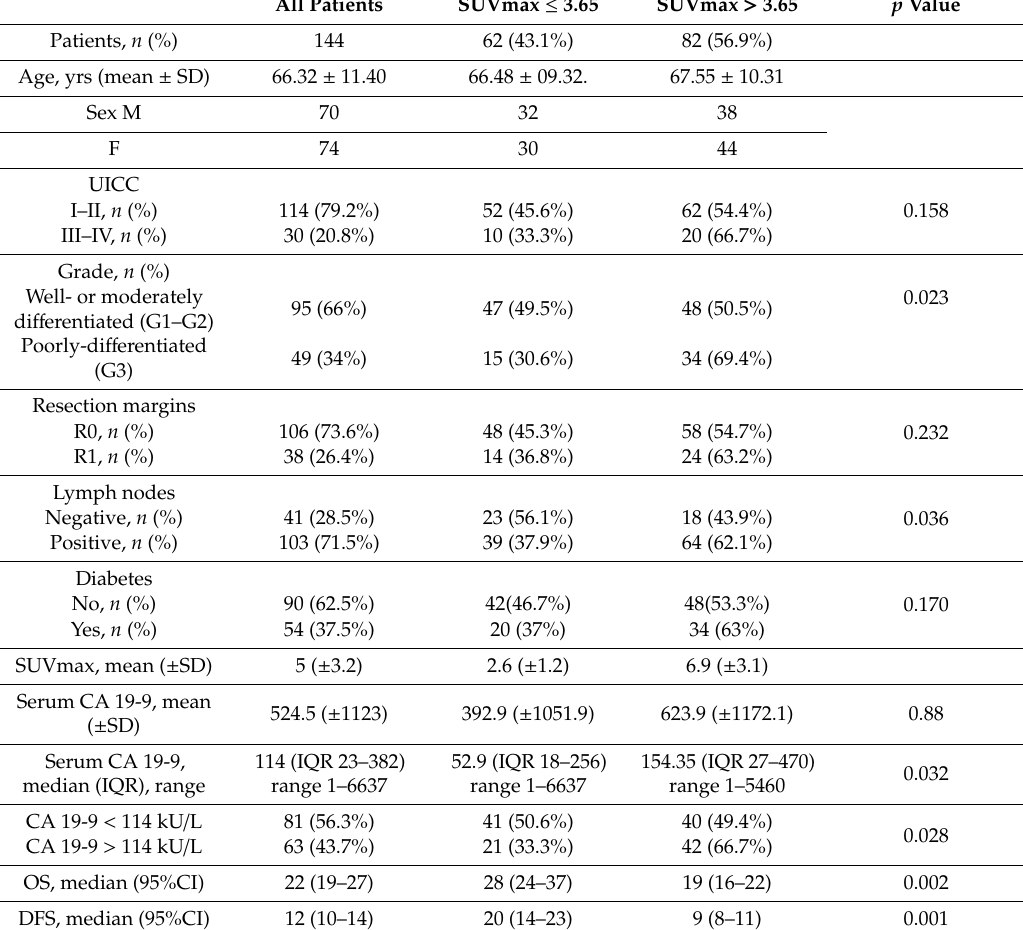
Table 1. Standardized Uptake Values and Patients’ Clinical and Pathological